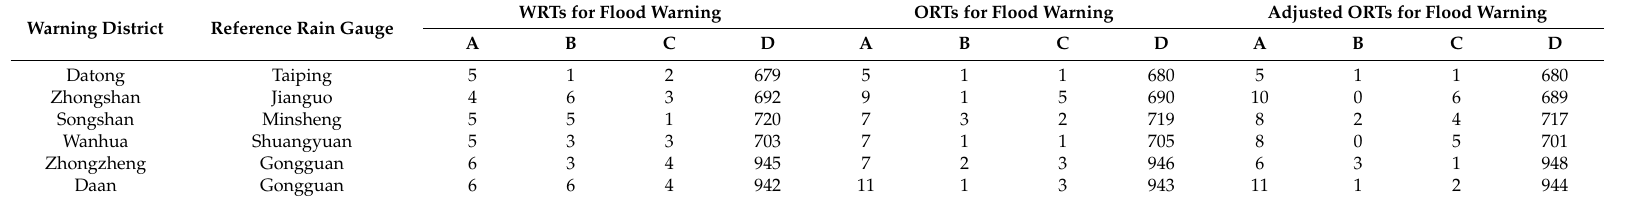
Table 5. Warning results of optimal rainfall thresholds (ORTs), adjusted ORTs and WRTs.